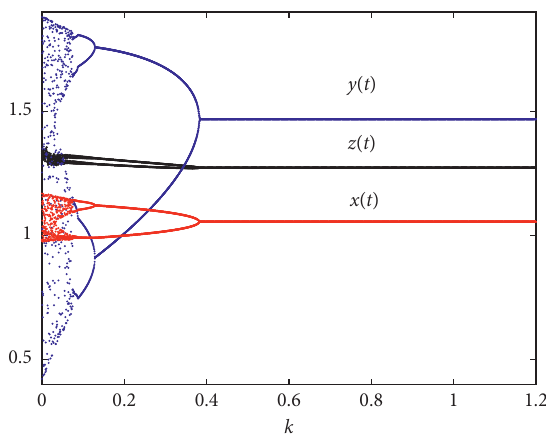
Figure 19: Bifurcation diagram with respect to k .